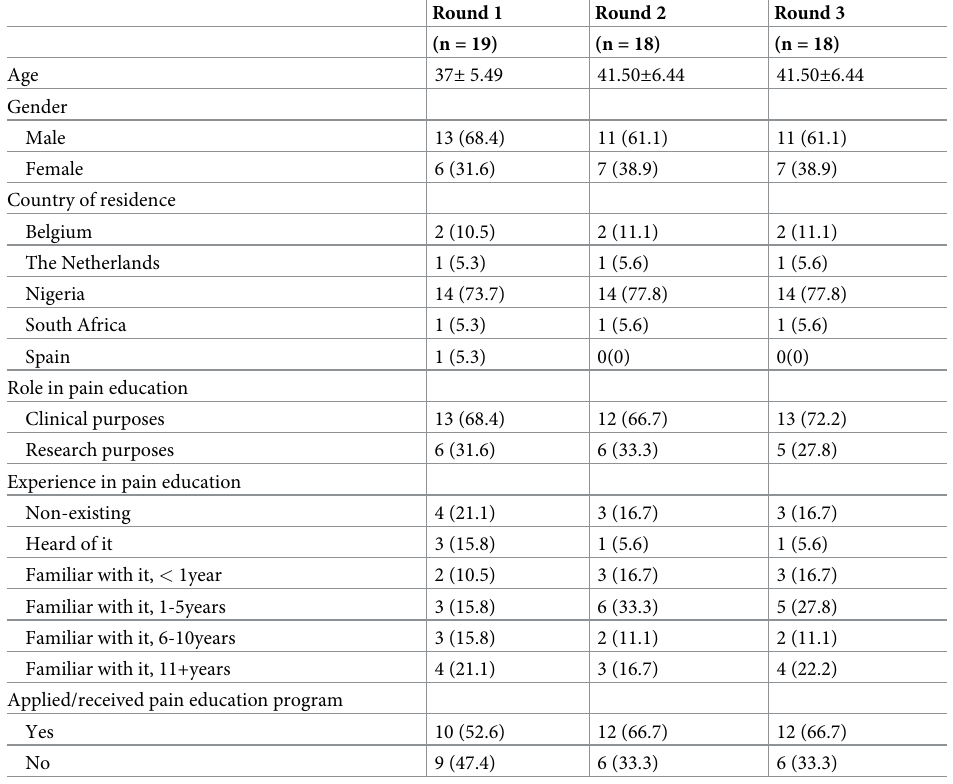
Table 1. Demographics of the experts that participated in the